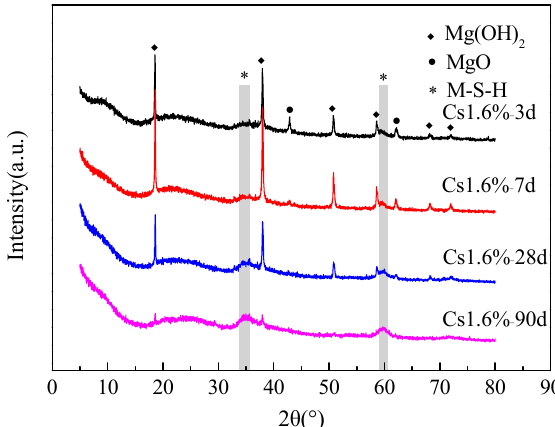
Figure 3. X-ray diffraction data of the M–S–H cement-solidified body with 1.6 wt % Cs + after 3, 7, 28 and 90 d.